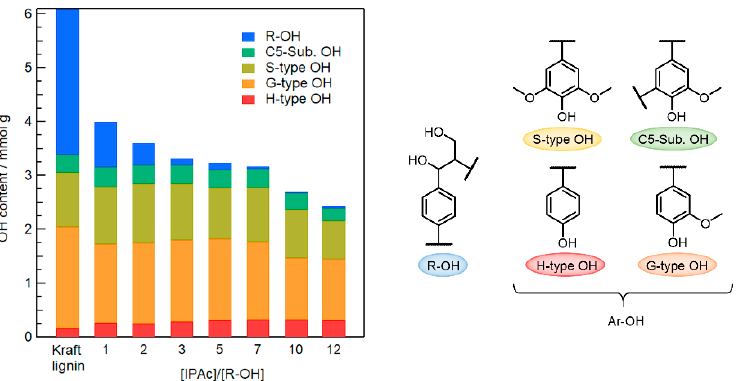
Figure 4. Changes in contents of R-OH and Ar-OH (H/G/S-type and C5-Sub. OH) groups in Kraft lignin before and after acetylation using different amounts of IPAc (1–12 Equations/[R-OH]) at 80 °C for 1 h and subsequent selective deacetylation with added water (2 Equations/[Ar-OH]) at 80 °C for 1 h in an EmimOAc/DMSO mixed system.